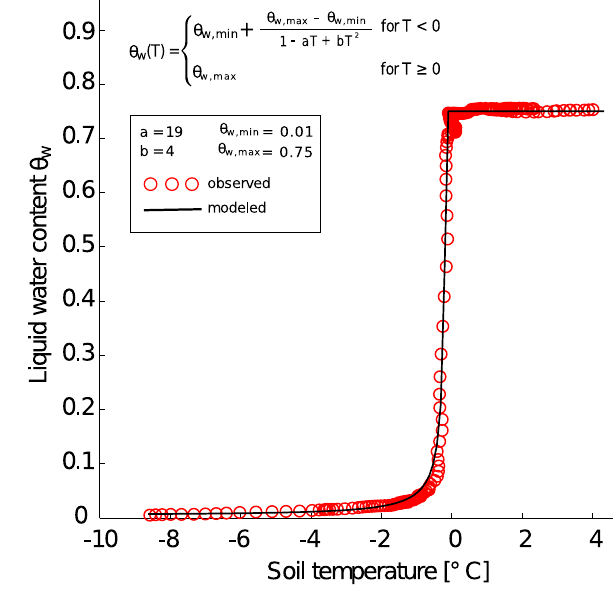
Fig. 3. The freezing characteristic of the soil at the study site which parameterizes the soil water content θ w in dependence to the soil temperature. The used polynomial function and the fitted parame- ters are depicted in the